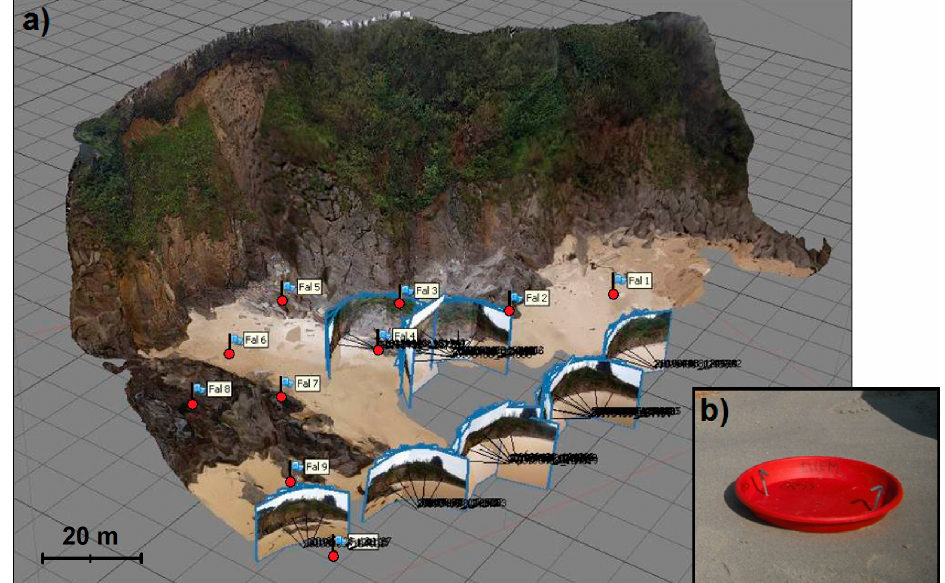
Figure 3. ( a ) Studied portion of the Porsmilin western cliff face and configuration of the Ground Control Points (GCPs) for the comparison of the different smartphones. ( b ) Example of target used as GCP.